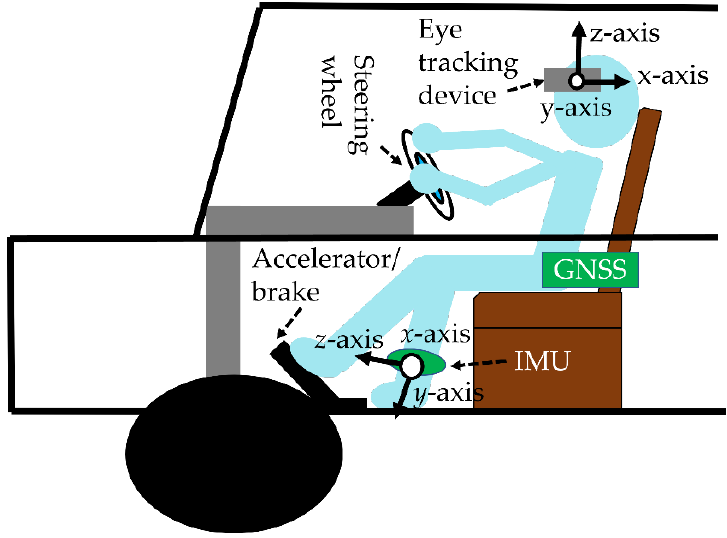
Figure 10. The subjects drive on a public road.